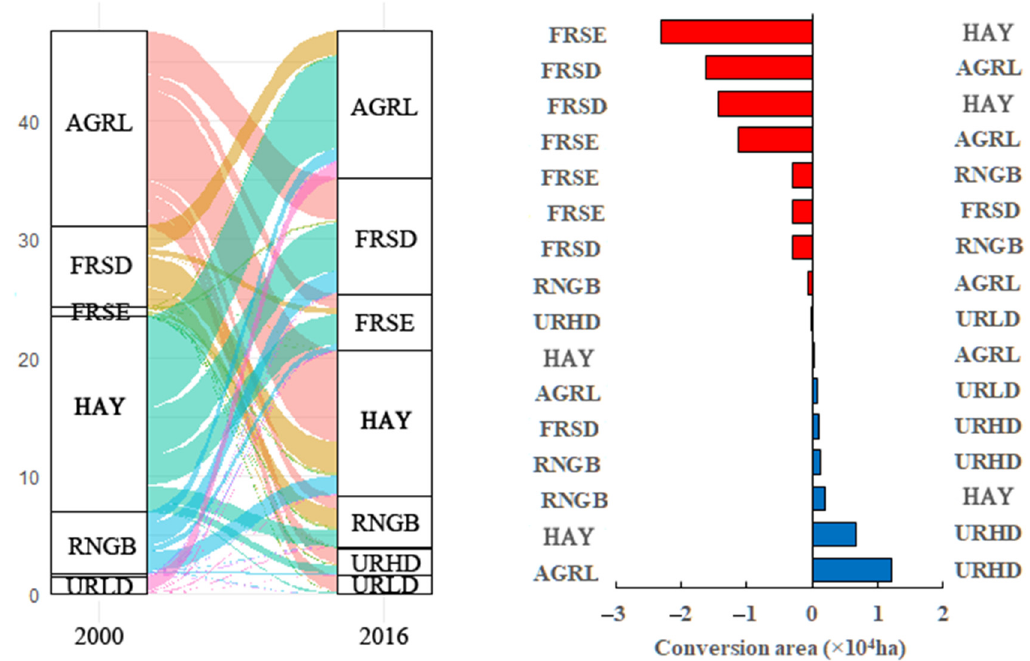
Figure 7. Land-use subclass conversions in the study area from 2000 to 2016. The right panel shows the net subclass conversions; only 16 change patterns with change areas greater than 100 ha are shown in the figure. Positive and negative values indicate the direction of land-use conversion. AGRL, FRSD, FRSE, HAY, RNGB, URHD, and URLD denote cropland, deciduous forest, evergreen forest, grassland, shrubland, urban, and township, respectively. The structure of land-use percentage has changed (Figure 8). The area of land use other than water bodies and barrens covered more than 97% of the entire study area. Land uses are mainly dominated by croplands, and the other types in descending order of area are grassland, forest, shrub, and settlement. The area of grassland, cropland, and shrub decreased by 1.97%, 1.86%, and 0.41%, respectively, in 2016 compared with 2000. The land use that increased in the area was forest and settlement, which increased by 3.32% and 1.04%, respectively.